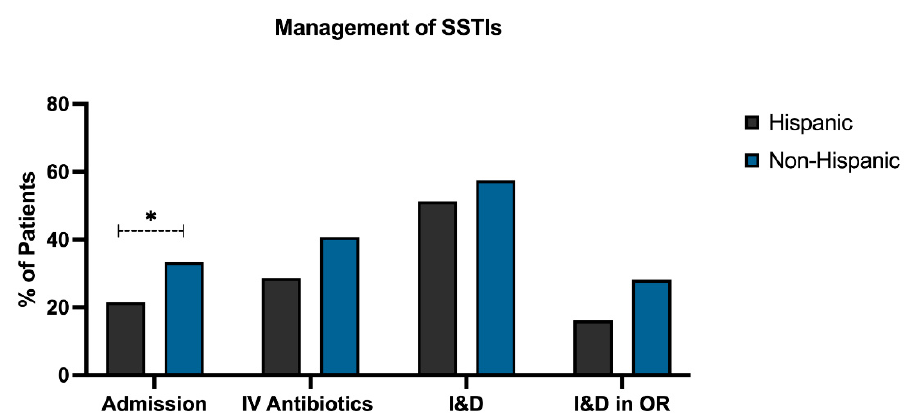
Figure 3. Variations in management of SSTIs based on ethnicity. Significantly more non-Hispanic patients were admitted (33.3%) compared to Hispanic patients (21.4%). Over forty percent of non-Hispanic patients received IV antibiotics (40.7%), while 28.6% of Hispanic patients received IV antibiotics. An I&D was performed in 51.2% of Hispanic patients and 57.4% of non-Hispanic patients. Of patients requiring an I&D, 28.1% of non-Hispanic patients received an I&D in the OR compared to 16.1% of Hispanic patients. SSTI, skin and soft-tissue infection; IV, intravenous; I&D, incision and drainage; OR, operating room. (* = p < 0.05).